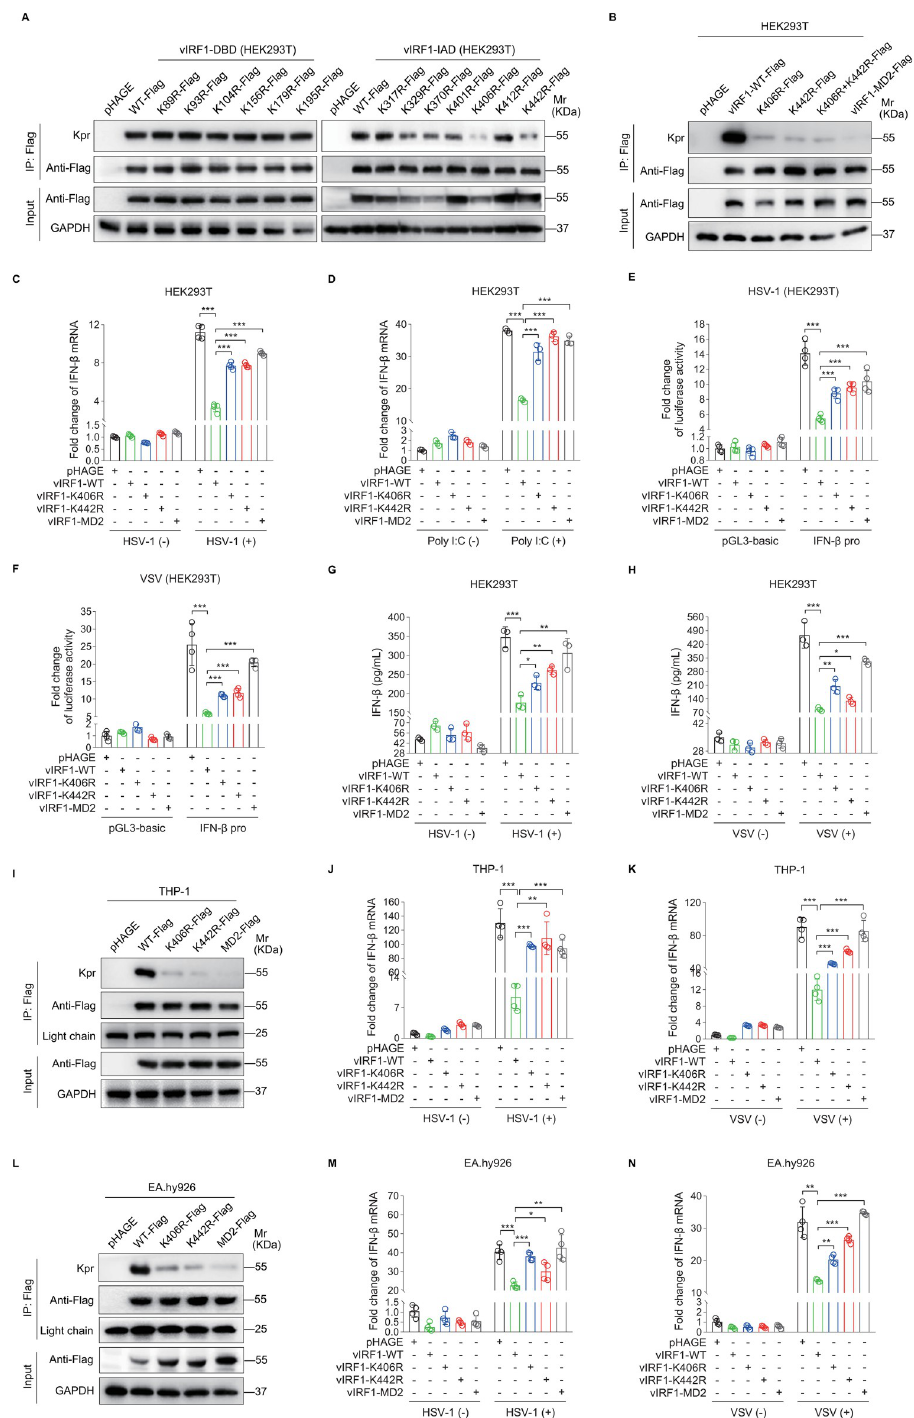
Fig 2. Propionyllysines in vIRF1 are identified in IFN antiviral response. (A). HEK293T cells transduced with lentiviral wild type vIRF1 ( WT-Flag ), the mutant forms ( K89R-Flag , K93R-Flag , K104R-Flag , K156R-Flag , K179R-Flag , K195R-Flag ) in DBD ( vIRF1-DBD ), the mutant forms ( K317R-Flag , K329R-Flag , K370R-Flag , K401R-Flag , K406R-Flag , K412R-Flag , K442R-Flag ) in IAD ( vIRF1-IAD ), or its control ( pHAGE ) were subjected to the anti-Flag immunoprecipitation, and the precipitated proteins were examined by Western blot with anti- propionyllysine ( Kpr ) antibodies. (B). HEK293T cells transduced with lentiviral wild type vIRF1 ( vIRF1-WT-Flag ), the mutant forms ( K406R-Flag , K442R-Flag , K406R+K442R-Flag ) in IAD, IAD-mutated vIRF1 ( vIRF1-MD2-Flag ),